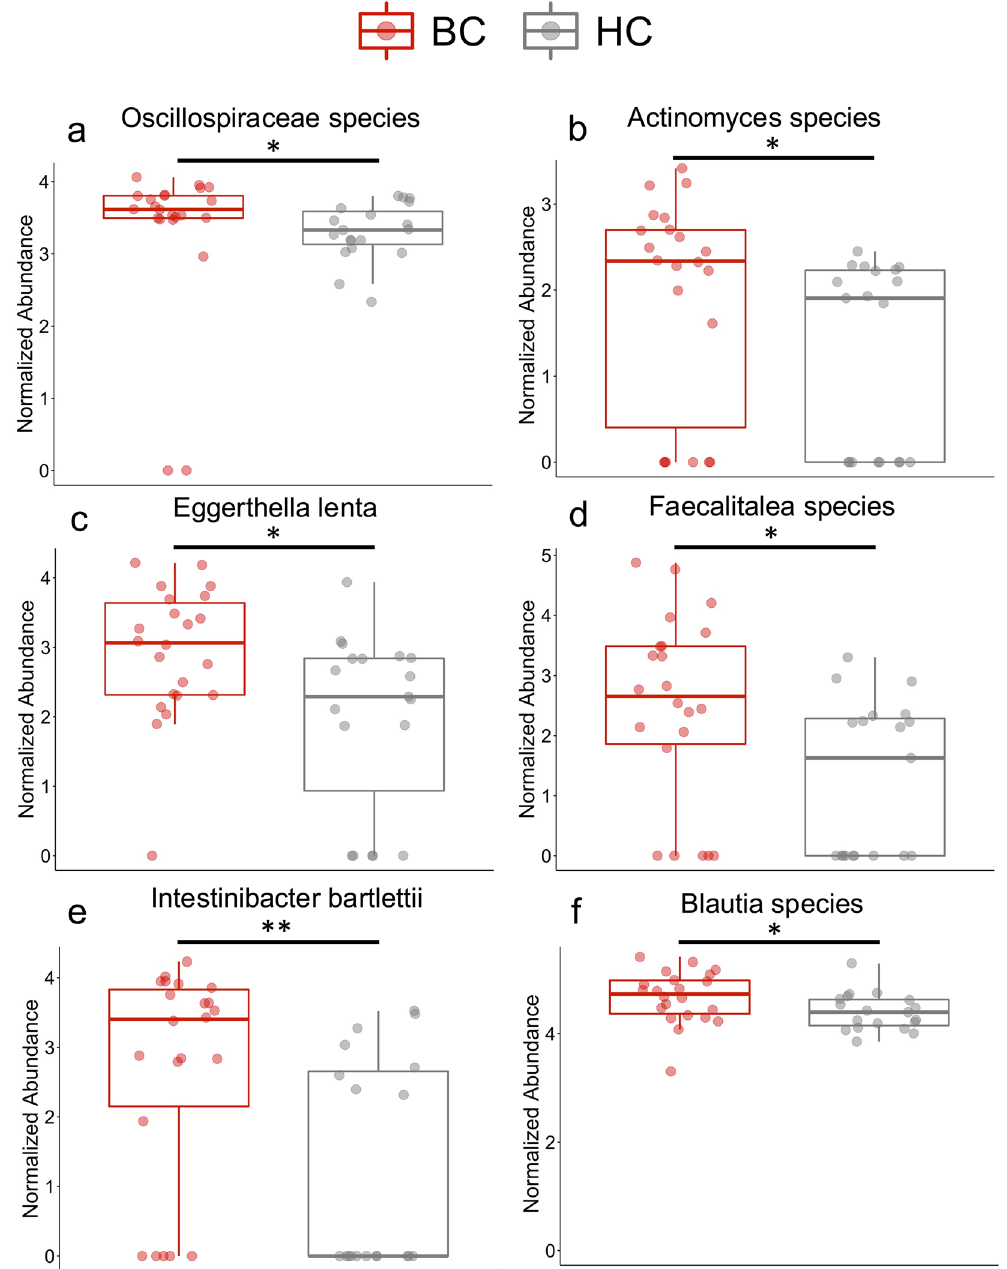
Figure 3. Bacteria significantly increased in patients with breast cancer compared to healthy controls. ( a – f ) Based on the Wilcoxon test and the Benjamini–Hochberg procedure, 6 features were significantly higher in abundance in the breast cancer cohort compared to the healthy controls ( p ≤ 0.05, q ≤ .15). Significance: * < 0.05 and ** <